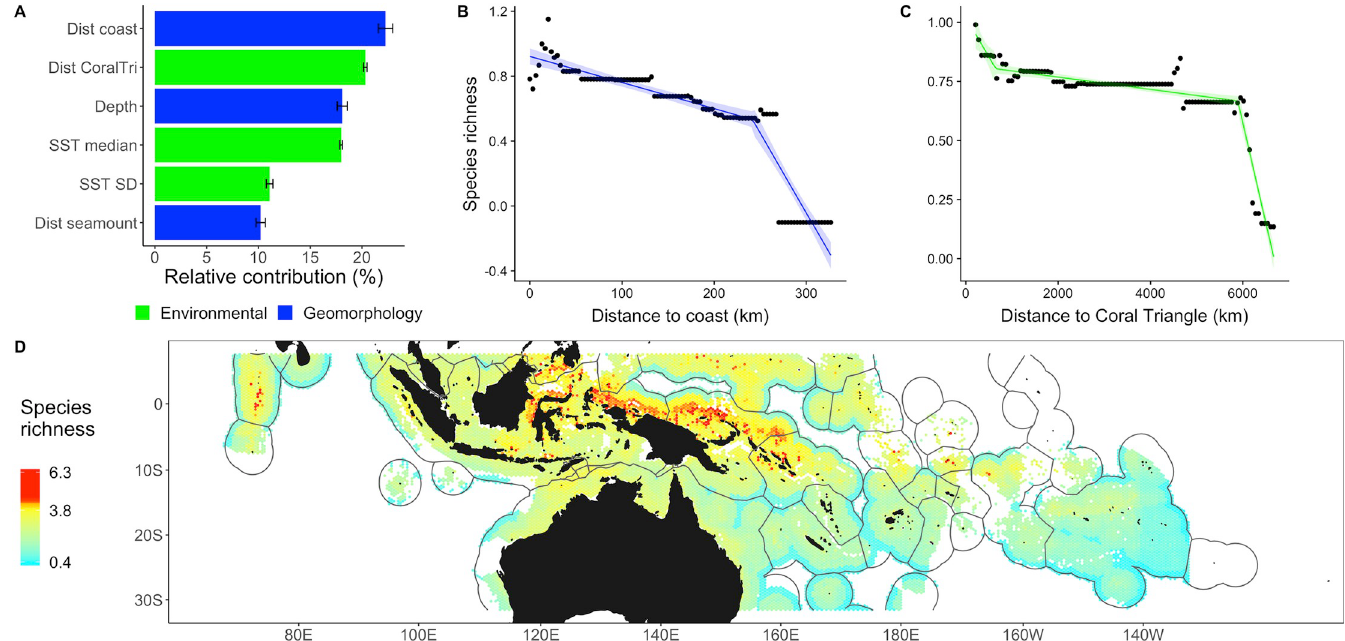
Fig 3. Drivers and patterns of vertebrate species richness in the Indo-Pacific. (A) Relative contribution of main drivers explaining variations in species richness were generated from 100 iterations of BRTs. (B, C) Partial dependence plot (lines), observed values (dots), and 95% confidence intervals for distance to the coast (B) and SST. (D) Predictions of species richness (top 5% values, > 3.8, in red). The numerical values for (A) can be found in S2 Data. BRT, boosted regression tree; dist coast, distance to nearest coast; dist CoralTri, distance to the Coral Triangle; dist seamount, distance to nearest seamount with summit depth < 1,500 m; SST, sea surface temperature.